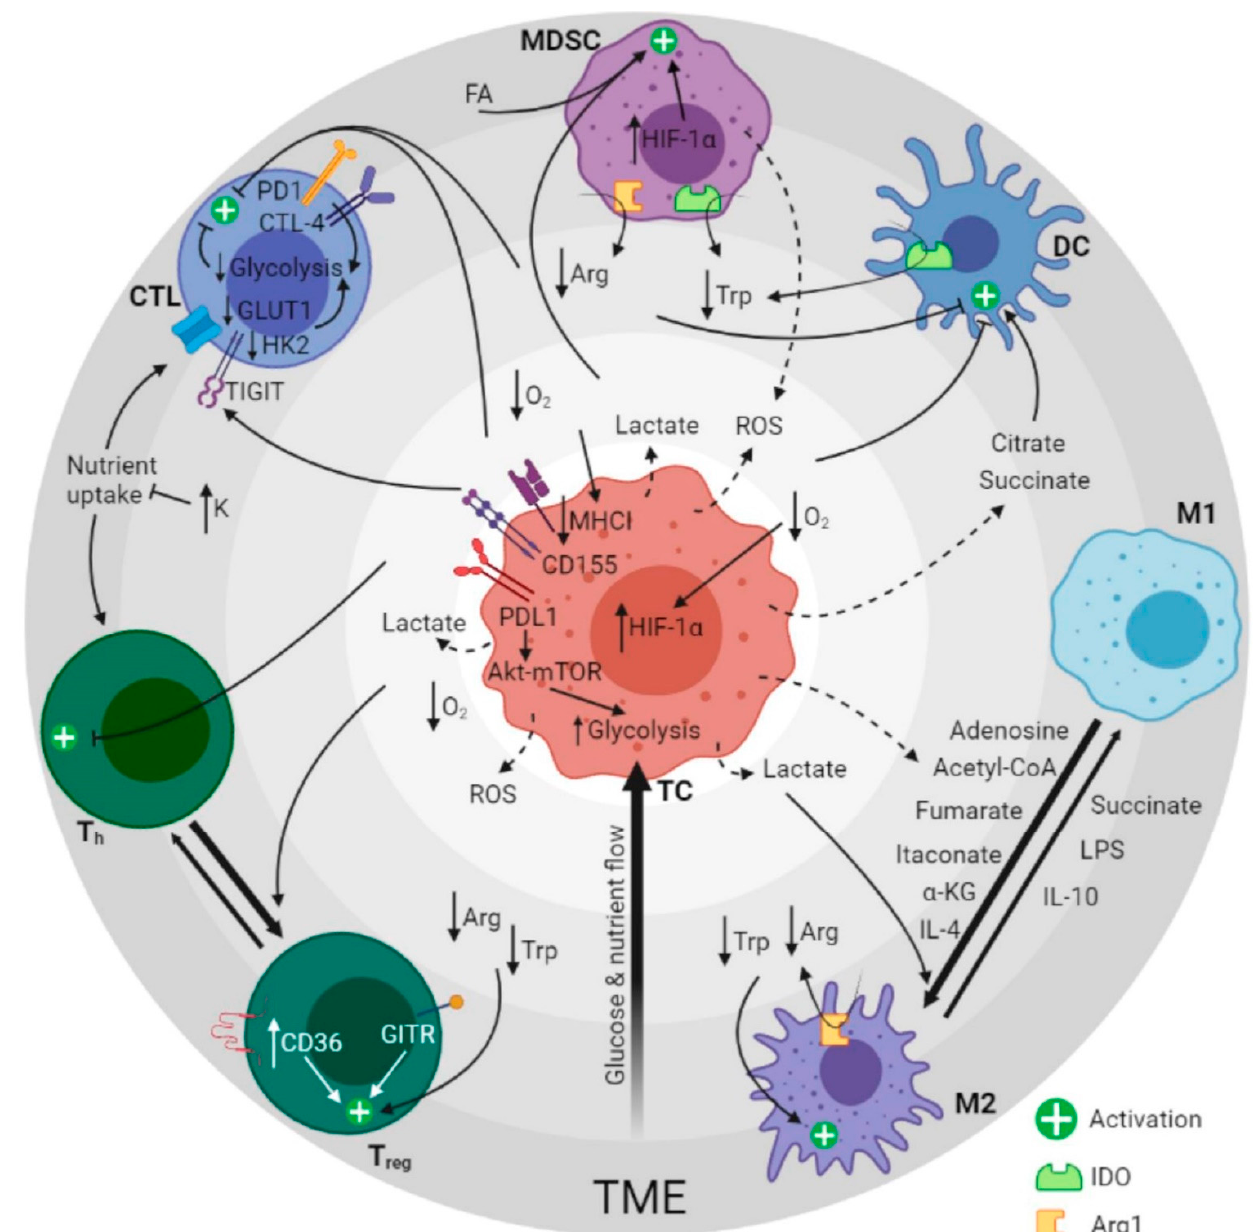
Figure 1. Graphical summary of the metabolic regulation of the immune response in cancer. The image depicts the crosstalking between tumor cells and immune cells by altering TME composition. Dashed arrows represent secretion of molecules, solid arrows indicate the effect of the molecules and bold arrows show immune cell type polarization direction. Concentric gray circles represent glucose and nutrient availability (dark gray = low, light gray = high) and define groups of related molecules participating synergistically in specific metabolic regulation pathways (i.e., lactate, low O 2 and ROS). TME: tumor microenvironment. MDSC: myeloid-derived stem cells. CTL: cytotoxic T cells. Th: T helpers. Treg: T regulatory cells. M2: macrophages type 2. M1: macrophages type 1. DC: dendritic cells. FA: fatty acids. Arg: arginine. Trp: tryptophan. ROS: reactive oxygen species. α‐ KG: alpha ‐ ketoglutarate. LPS: lipopolysaccharide. IDO: indoleamine ‐ pyrrole 2,3 ‐ dioxygenase. Arg1: arginase ‐ 1. Created with BioRender.com (accessed date: 13 June 2021).